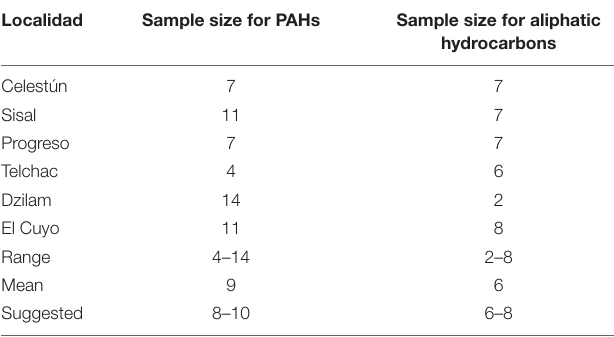
TABLE 3 | Sampling effort for estimation of hydrocarbons in sediments from intertidal strata of sandy beaches in Yucatán State, with a precision of 0.2. Localidad Sample size for PAHs Sample size for aliphatic